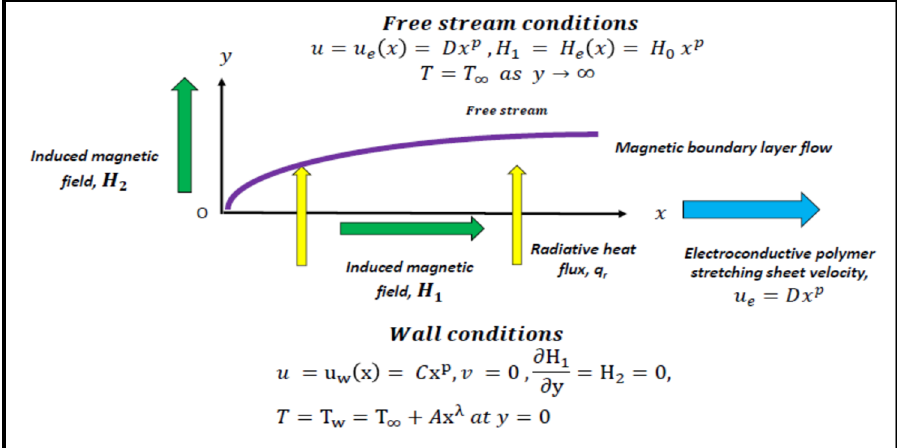
Figure 1. Magnetic boundary layer convection-radiation flow from a stretching surface.